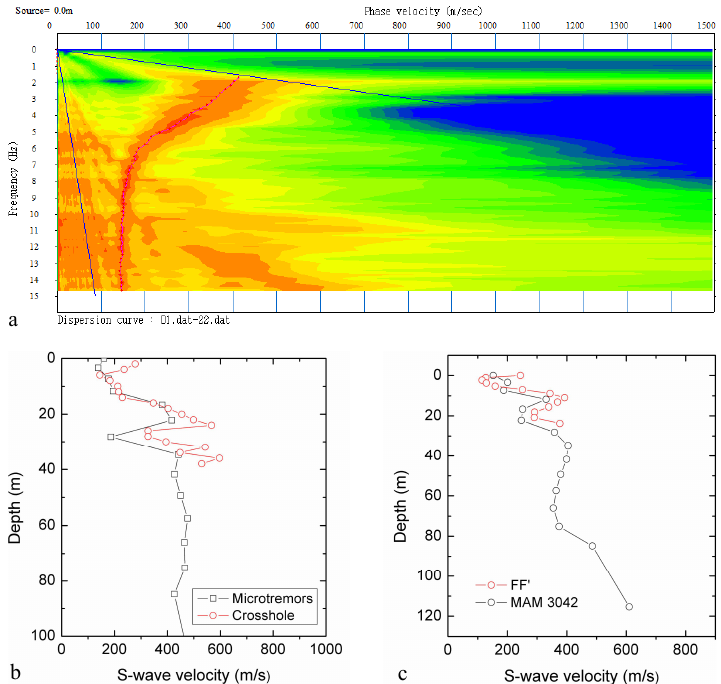
Fig. 8. (a) An example dispersion curve from a Multichannel analysis of microtremors at the site G1. (b) The resulted 1-D velocity model of the passive survey was in a good agreement with the crosshole testing conducted nearby. (c) The 1-D Vs model at the site